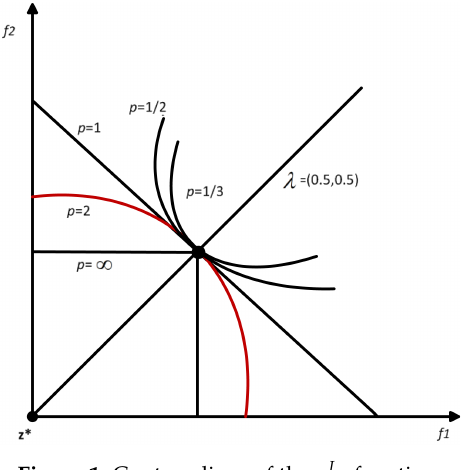
Figure 1. Contour lines of the g L p